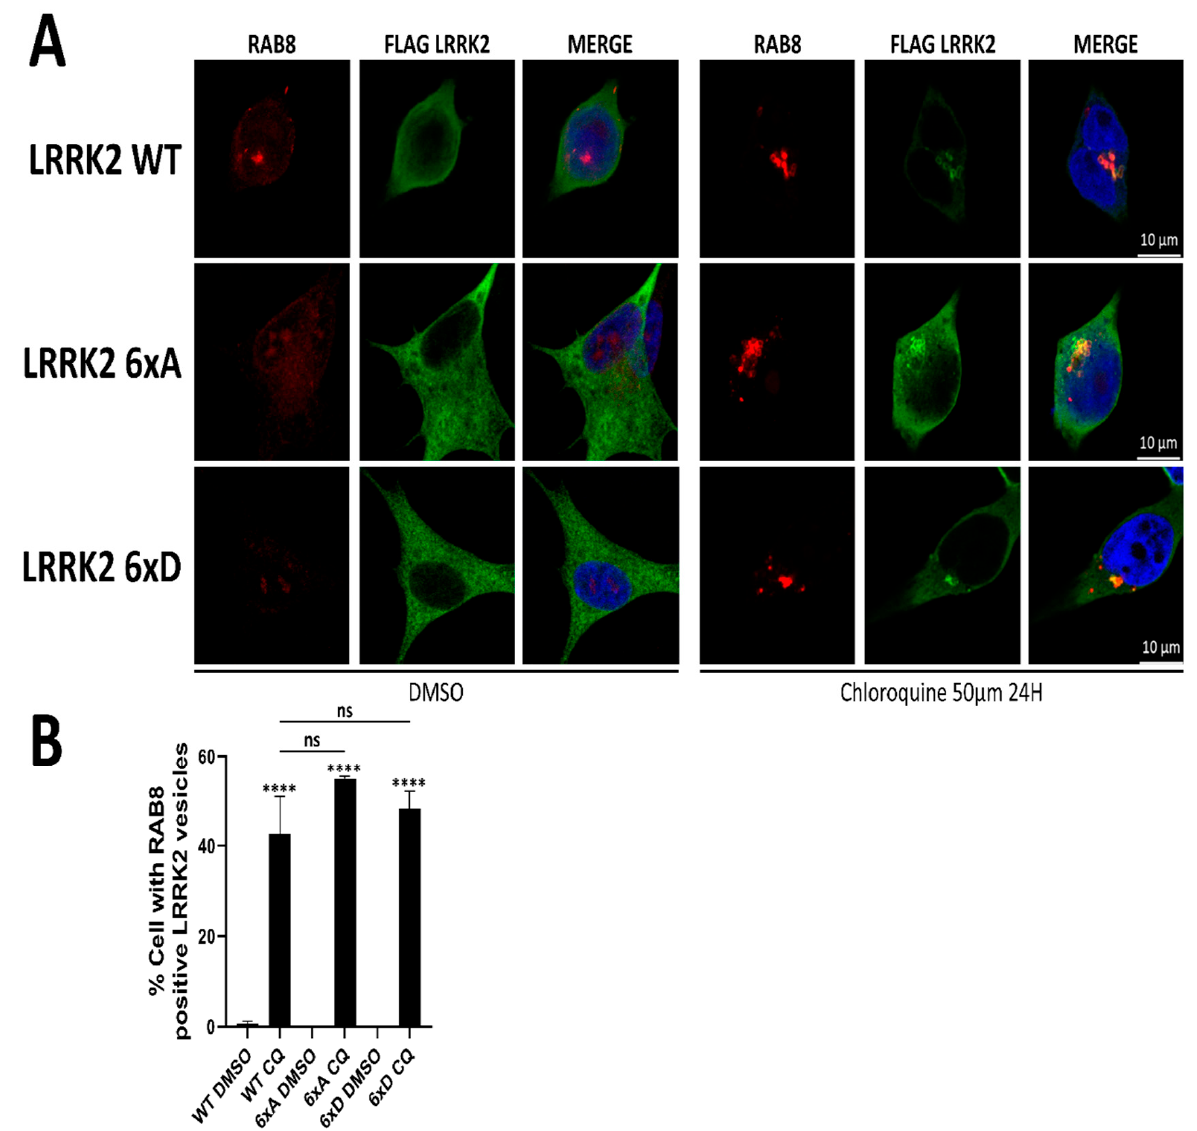
Figure 6. LRRK2 relocalizes to RAB8a positive structures after chloroquine treatment. ( A ) SH-SY5Y stably expressing LRRK2 were treated with 50 µM of chloroquine for 24 h prior fixation. ( B ) Quantification of the percentage of cells presenting RAB8a positive LRRK2 vesicles. Data are mean ± SEM (n = 3 independent experiments, 100–130 cells were analyzed per mutant in each experiment). The data were analyzed by One-way-ANOVA followed by Tukey’s test for multiple comparisons. (**** p < 0.0001, ns = non significant).